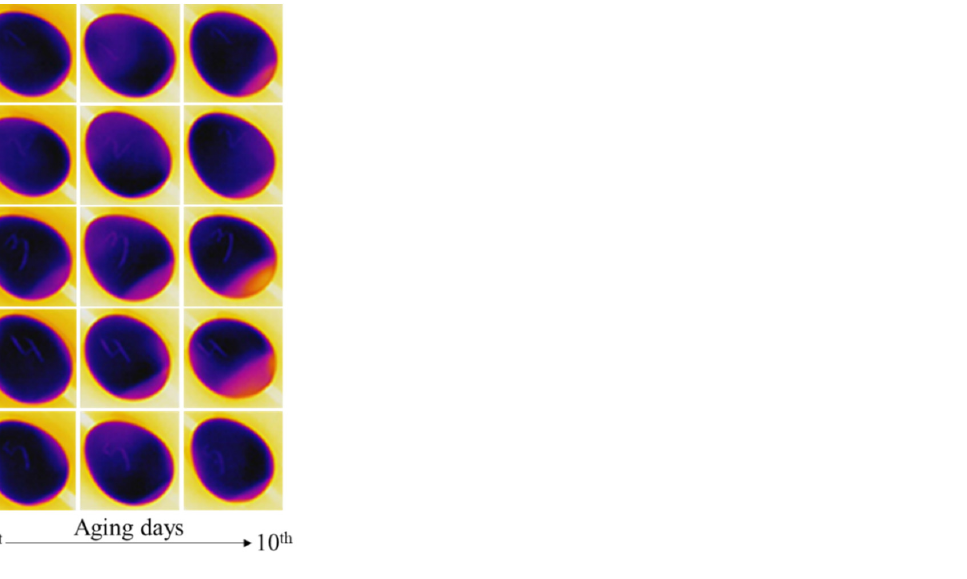
Figure 9. The aging effects on eggs after 10 days of storage under accelerated aging conditions of 28 °C and 60% humidity.